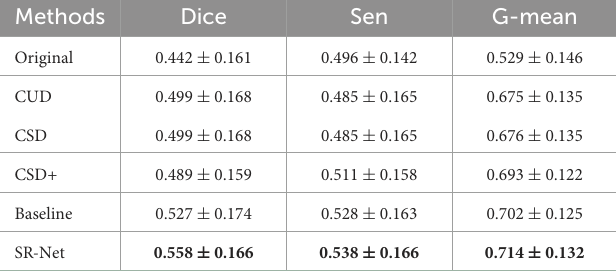
TABLE 4 Vessel segmentation performance on original images in AS-OCTA dataset and their de-striped versions via different methods.